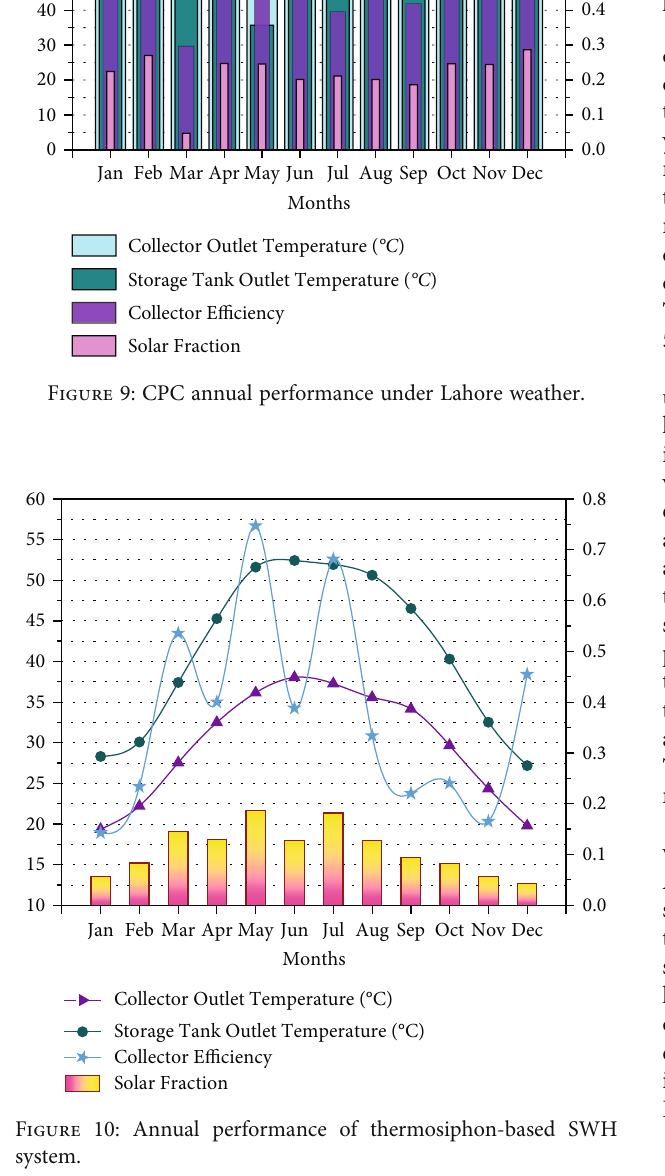
Figure 10: Annual performance of thermosiphon-based SWH